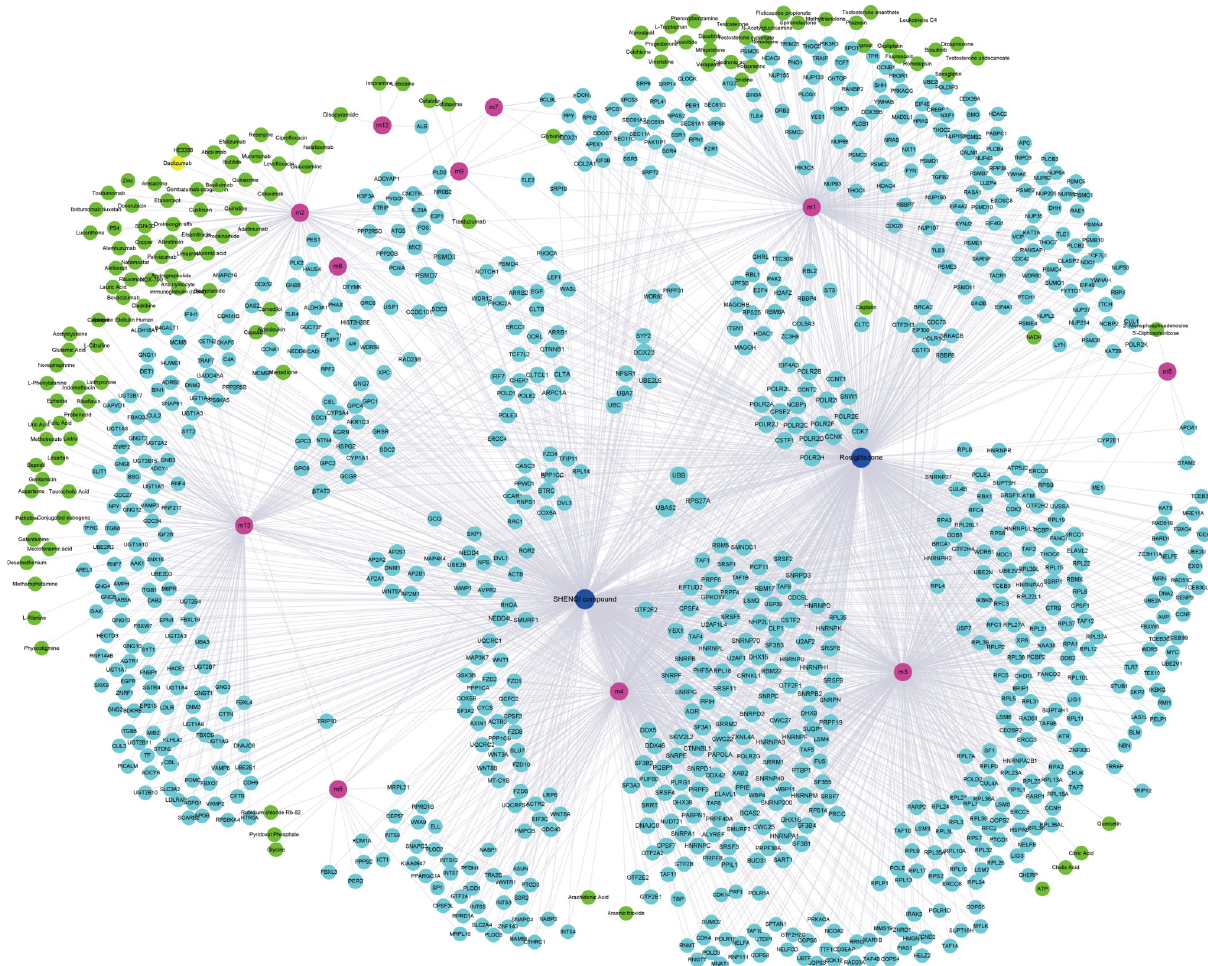
Fig 7. The significant relationships between drugs and modules. The red circle represents the module. The blue nodes represent the SHENQI compound and rosiglitazone and the green circle represent other potential drugs. The cyan node represents the potential targets of SHENQI compound and